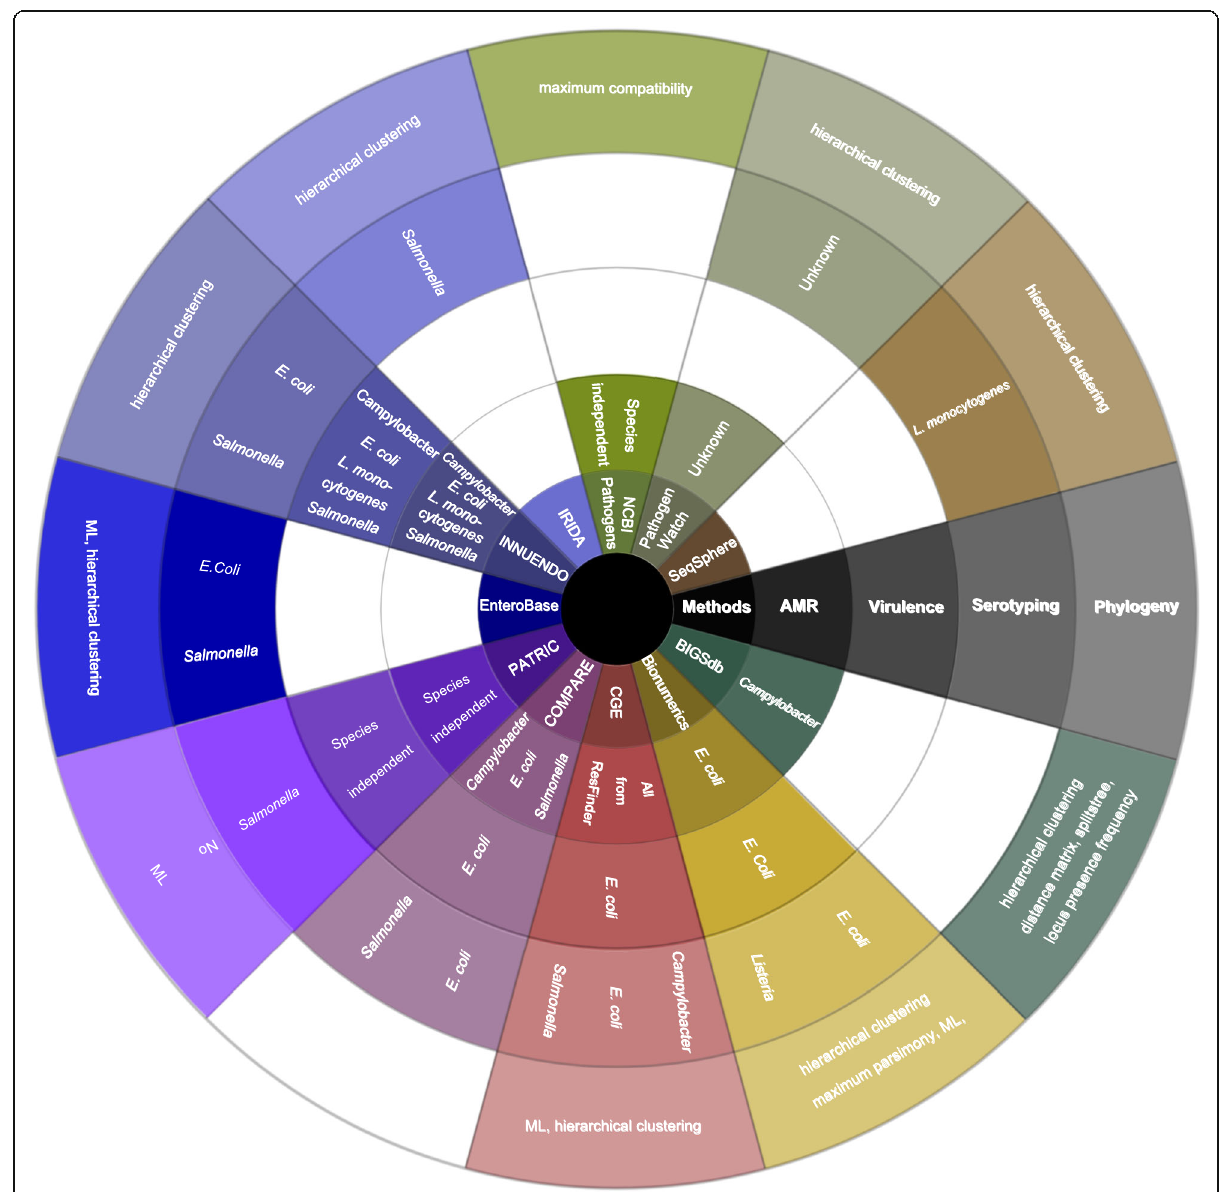
Fig. 1 Wheel of tools and supported methods. Provided methods: Antimicrobial resistance gene detection (AMR), Virulence factor search (Virulence), Serotyping and Phylogeny (highlighted in black/grey) by selected tools (BIGSdb, Bionumerics, CGE, COMPARE, PATRIC, EnteroBase, INNUENDO, IRIDA, NCBI Pathogens, PathogenWatch and SeqSphere). Organisms for which a methodology is supported by a tool are specified. For phylogeny, the underlying methods are mentioned. White fields indicate that functionality is not supported by the respective platform. ML = Maximum